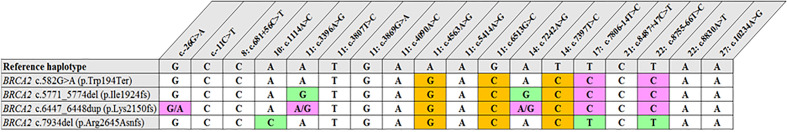
Shared haplotype of recurrent pathogenic variants. The core haplotype associated with each variant is represented by 18 SNPs spread throughout BRCA2. A core haplotype was observed for three of the four pathogenic mutation carriers representing a specific, actionable variant but was inconsistent in the control chromosomes. The pink blocks represent an alternative allele to that of the reference, whereas the blocks highlighted in green indicate unique genotypes associated with the specific variant.